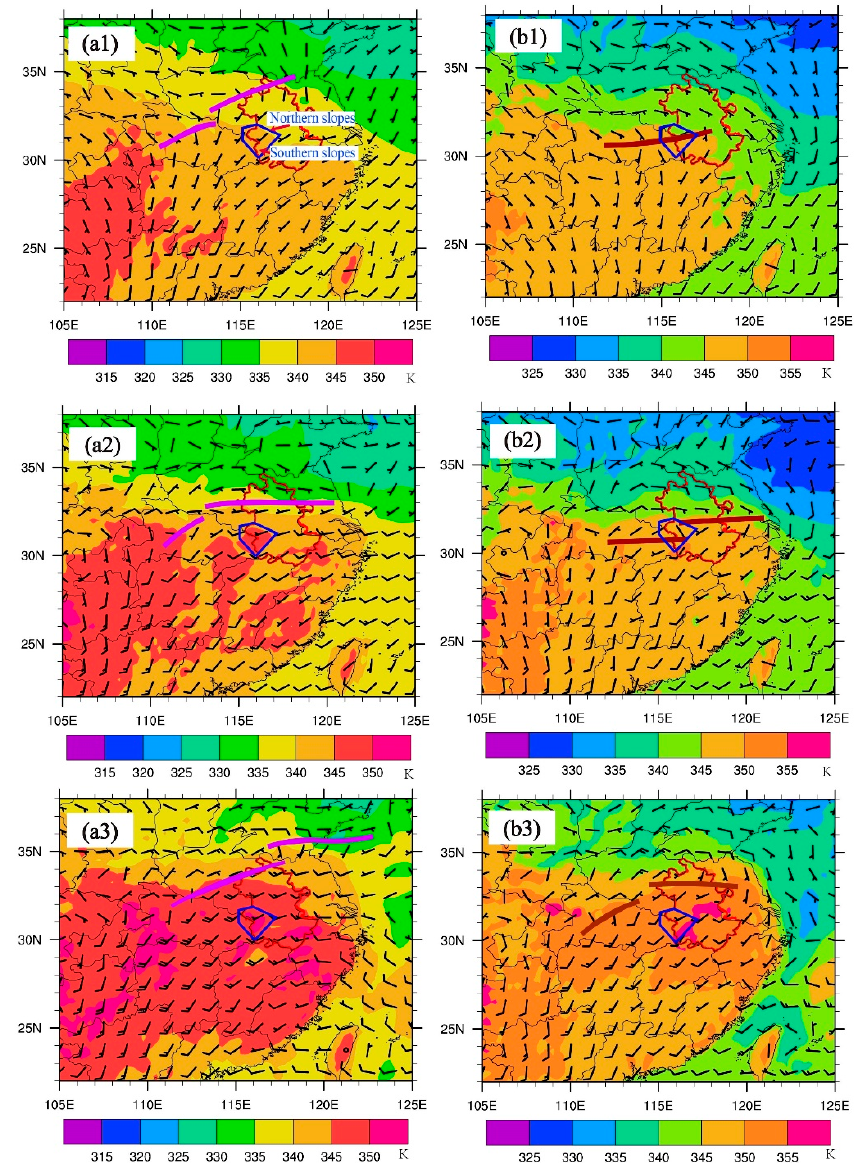
Figure 10. Horizontal wind at low levels (850 and 925 hPa, barbs, the full barb represent 4 m / s) and pseudo equivalent potential temperature (shaded, unit: K) of ( a1 , b1 ) LCDM, ( a2 , b2 ) ‘South-Type’ and ( a3 , b3 ) ‘North-Type’. ( a1 – a3 ) represent 850 hPa. ( b1 – b3 ) represent 925 hPa. The purple and brown solid line represents shear line at 850 and 925 hPa, respectively. The blue polygon represents the Dabie